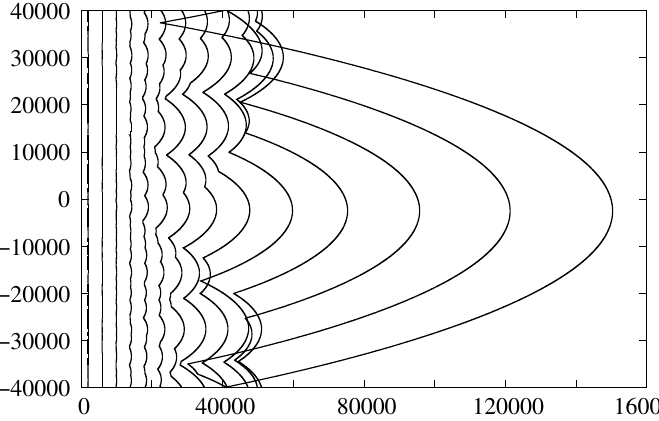
( 0 ) vs. t for the model (2)–(4); G = 0.002, Λ = 80,000, N = 2 15 . t